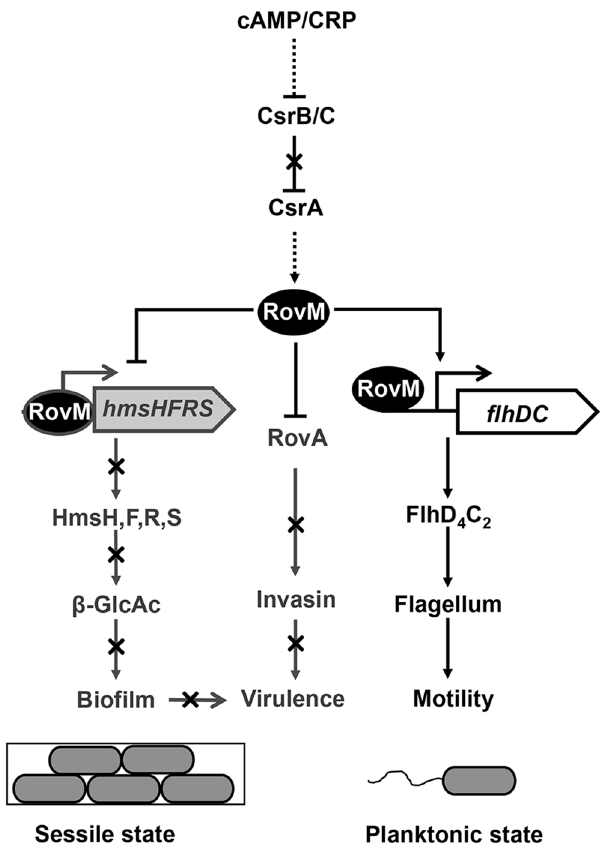
Figure 7. Model for controlling biofilm/motility transition by RovM. CsrA is activated by the cAMP-Crp complex through reducing the amount of CsrB/C. RovM regulator activated by CsrA enhances bacterial motility by directly activating flhDC expression while inhibiting β -GlcNAc accumulation by directly repressing the expression of the hmsHFRS operon. Thus, RovM formed a switch modulates motility/biofilm transition on transcriptional level. In the meanwhile, RovM represses bacterial virulence through negative regulation of RovA and inhibition of biofilm